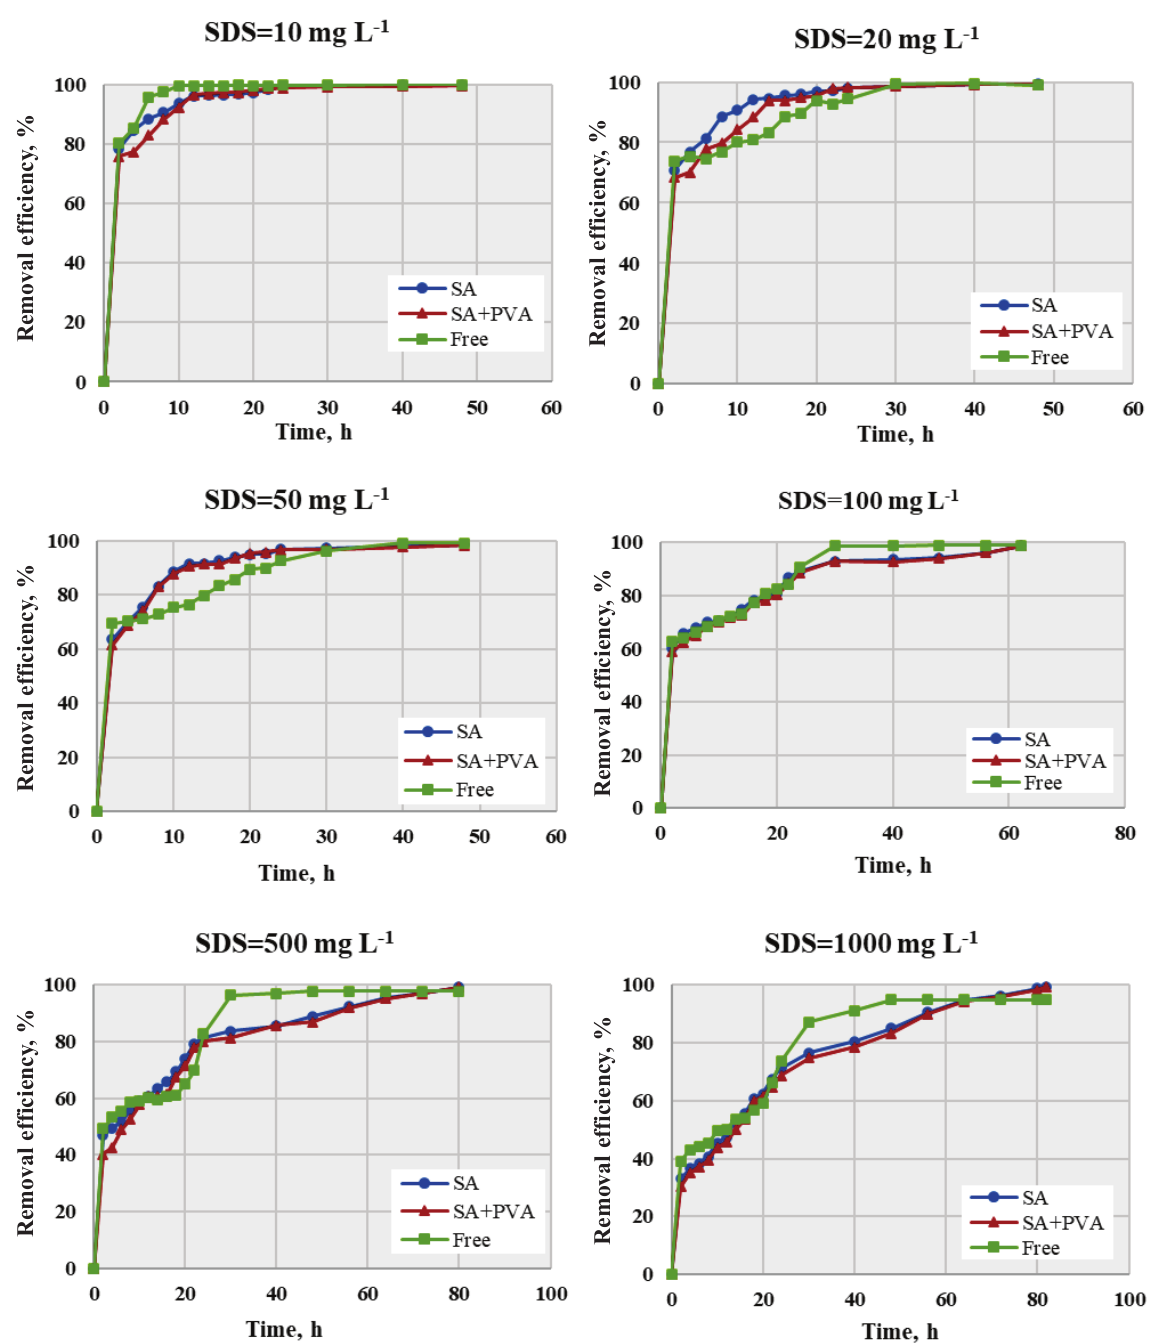
Fig. 2 – Biodegradation of different concentrations of SDS in synthetically prepared solution by free and immobilized